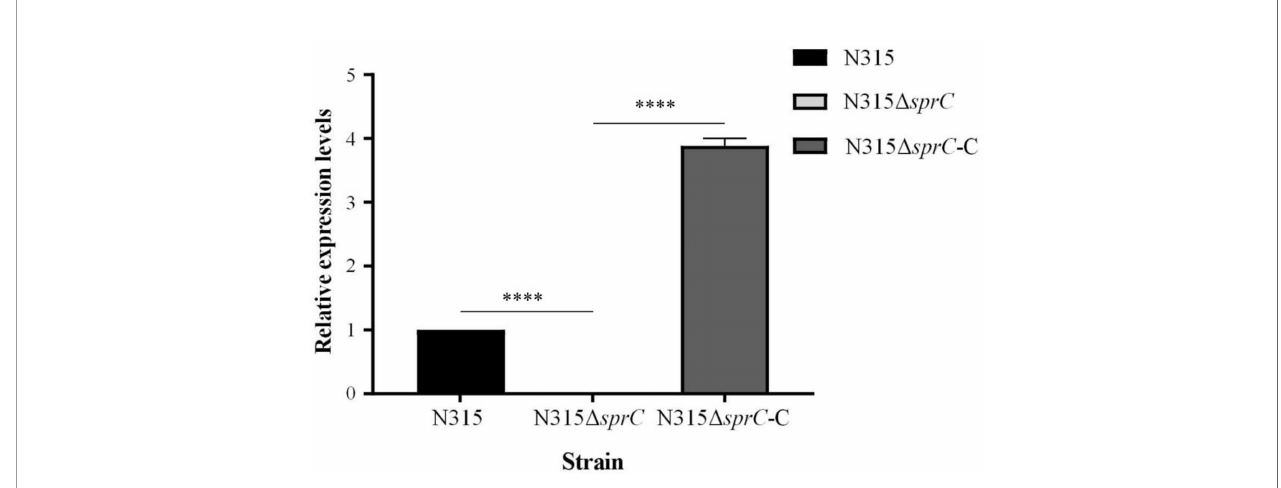
FIGURE 5 | Relative expression of sprC in N315 wild-type, knockout and complementation strains. The knockout strain (N315 D sprC ) was constructed via temperature-sensitive plasmid pKOR1 by homologous recombination. The complementation strain (N315 D sprC -C) was constructed by transferring recombinant plasmid pOS1- sprC into strain N315 D sprC via electroporation. The levels of expression of sprC in the three strains were detected by qRT-PCR. The sprC is barely expressed in the knock out strain N315 D sprC , and restored to the level of wild-type strain in the complementation strain N315 D sprC -C. black bar, N315, the wild-